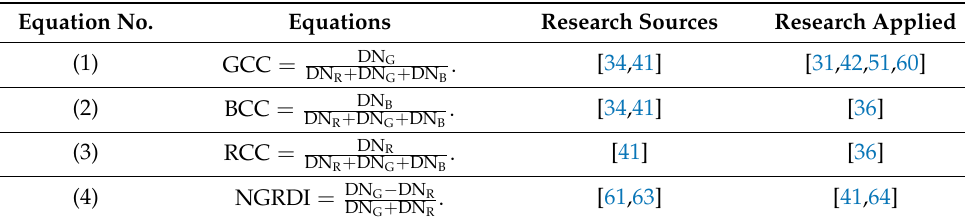
Table 1. Red, green, blue chromatic coordinate indices (RCC, GCC, BCC, respectively) and normalized green–red difference index (NGRDI) greenness indices derived from the phenocam images. Note: DN = digital number; R, G, and B = red, green, and blue bands, respectively). Equation No. Equations Research Sources Research